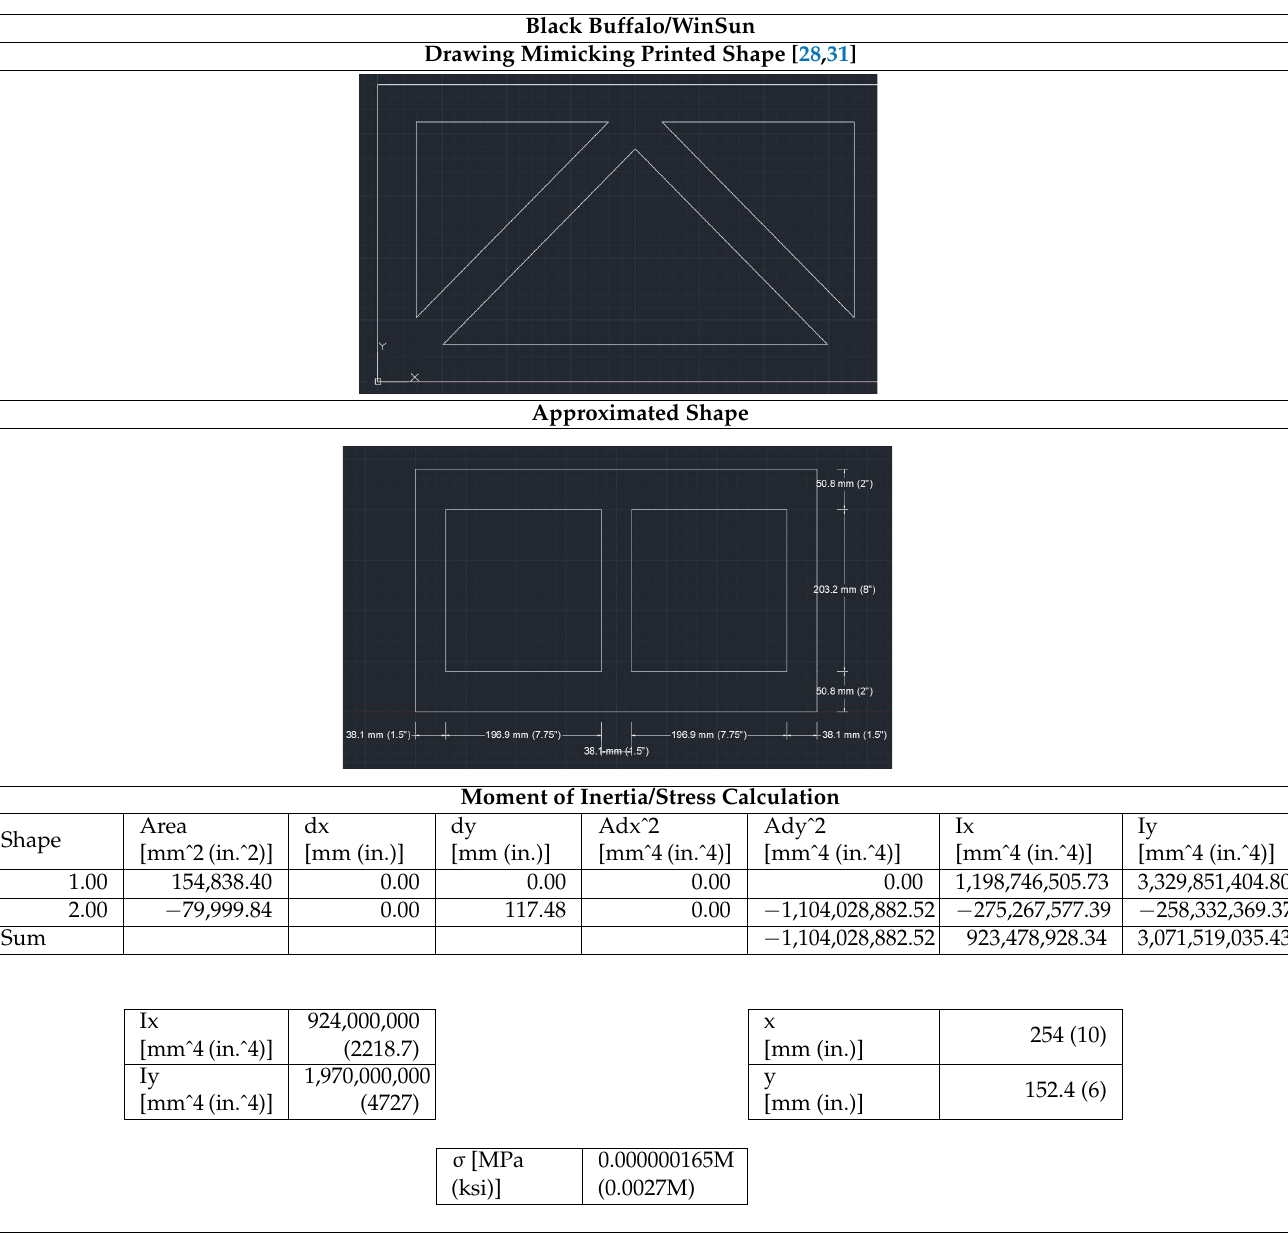
Table A3. Black Buffalo/WinSun wall calculations